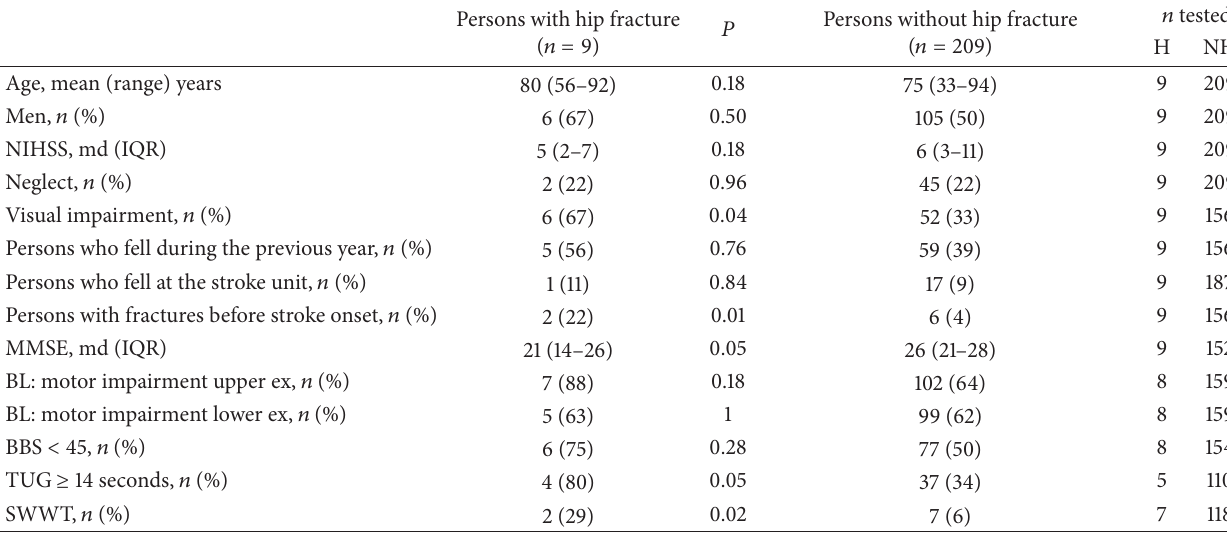
Table 3: Characteristics of persons admitted to the stroke unit ( 𝑛 = 218 ) with hip fracture (H) and without hip fracture (NH).